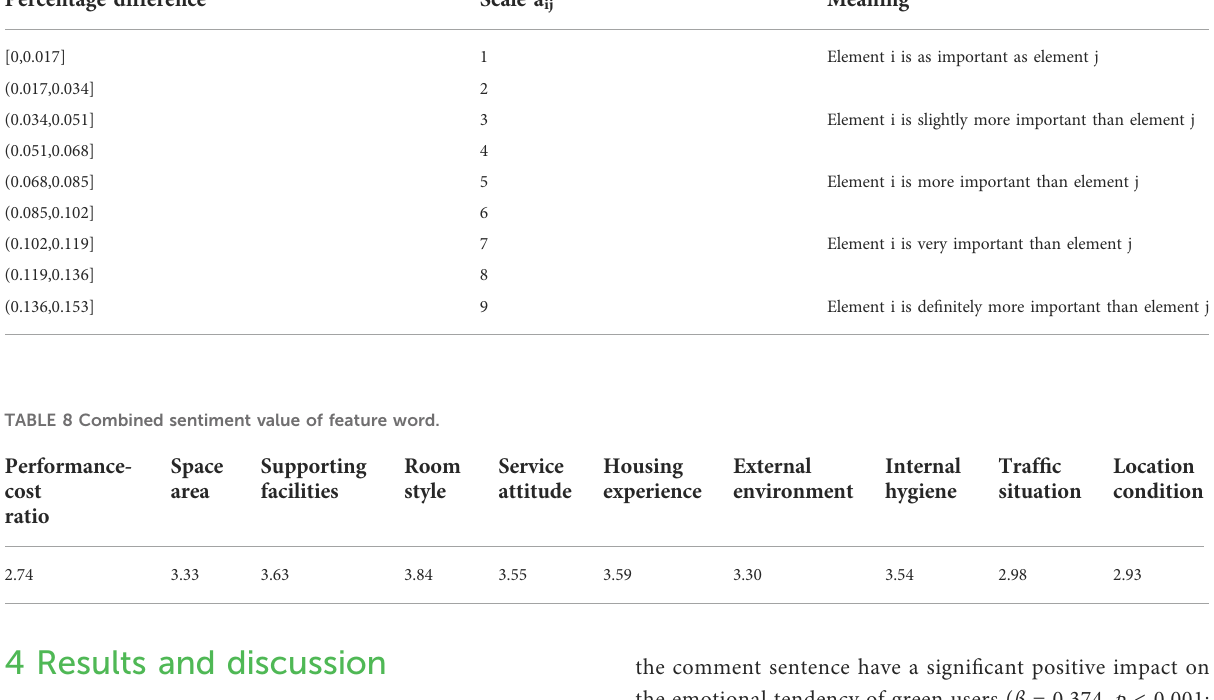
TABLE 7 Scale division index table.